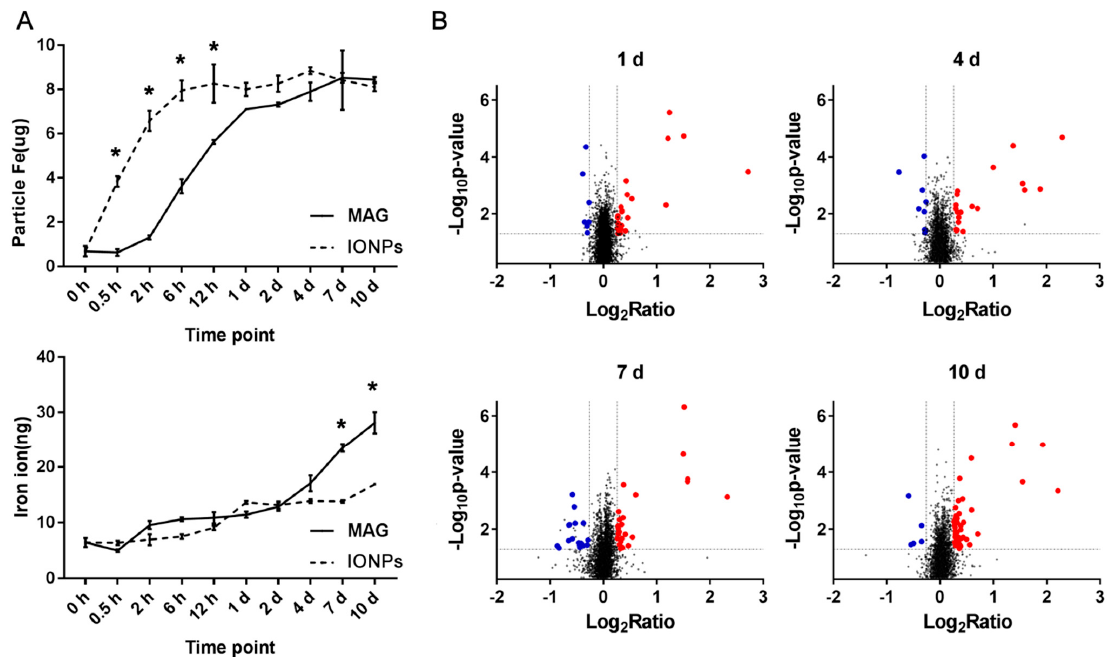
Figure 4. Intracellular iron concentrations of ECs treated with nanoparticles and overview of the identified proteins in ECs treated with MAGs. ( A ) Inductively coupled plasma-mass spectrometry (ICP-MS) analysis of insoluble iron particles (particle Fe) and soluble iron (iron ion) amount at different timepoints in ECs treated with MAGs or IONPs (10 μ g Fe/mL). Data are shown as mean ± SD, n = 3 for each timepoint, and * p -value < 0.05 means the amount of insoluble iron particles or released iron ion is significantly different between IONPs and MAGs treated ECs. ( B ) Scatter plots of quantitative proteomics results of ECs treated with MAGs compared to the control. Blue and red dots represent the decreased and increased proteins in ECs at days 1, 4, 7, and 10, respectively. The ratio represents the average ratio of each protein quantified from three biological replicates. Control, ECs without MAGs